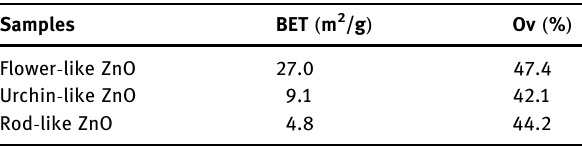
Table 2: Speci fi c surface areas and oxygen vacancy concentration of ZnO with di ff erent morphologies Samples Flower - like